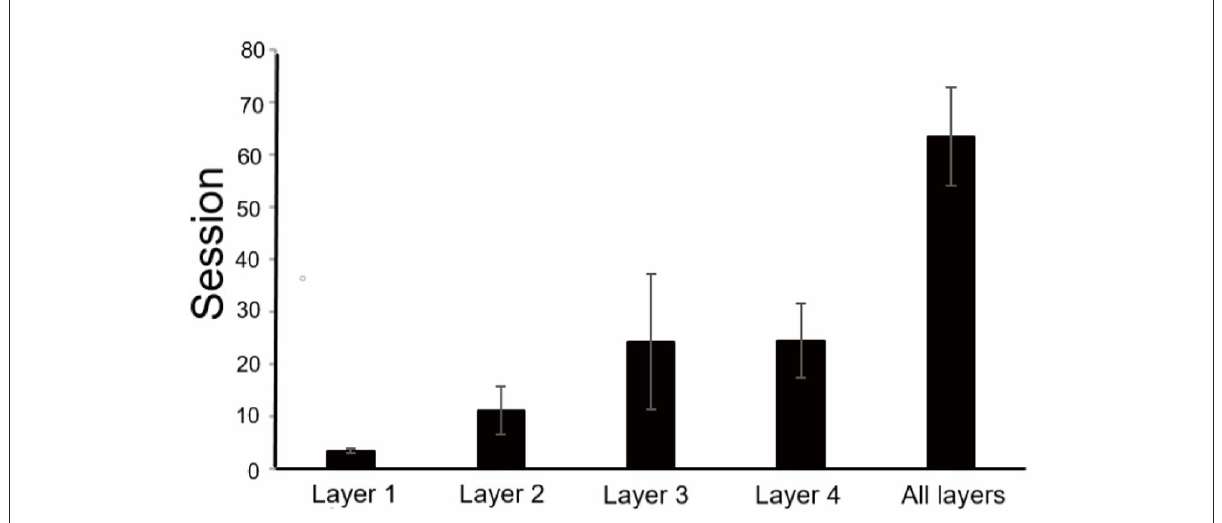
FIGURE4 Training results of the finger maze test. An average number of sessions to reach the criterion for each layer and the total number of sessions to complete training.